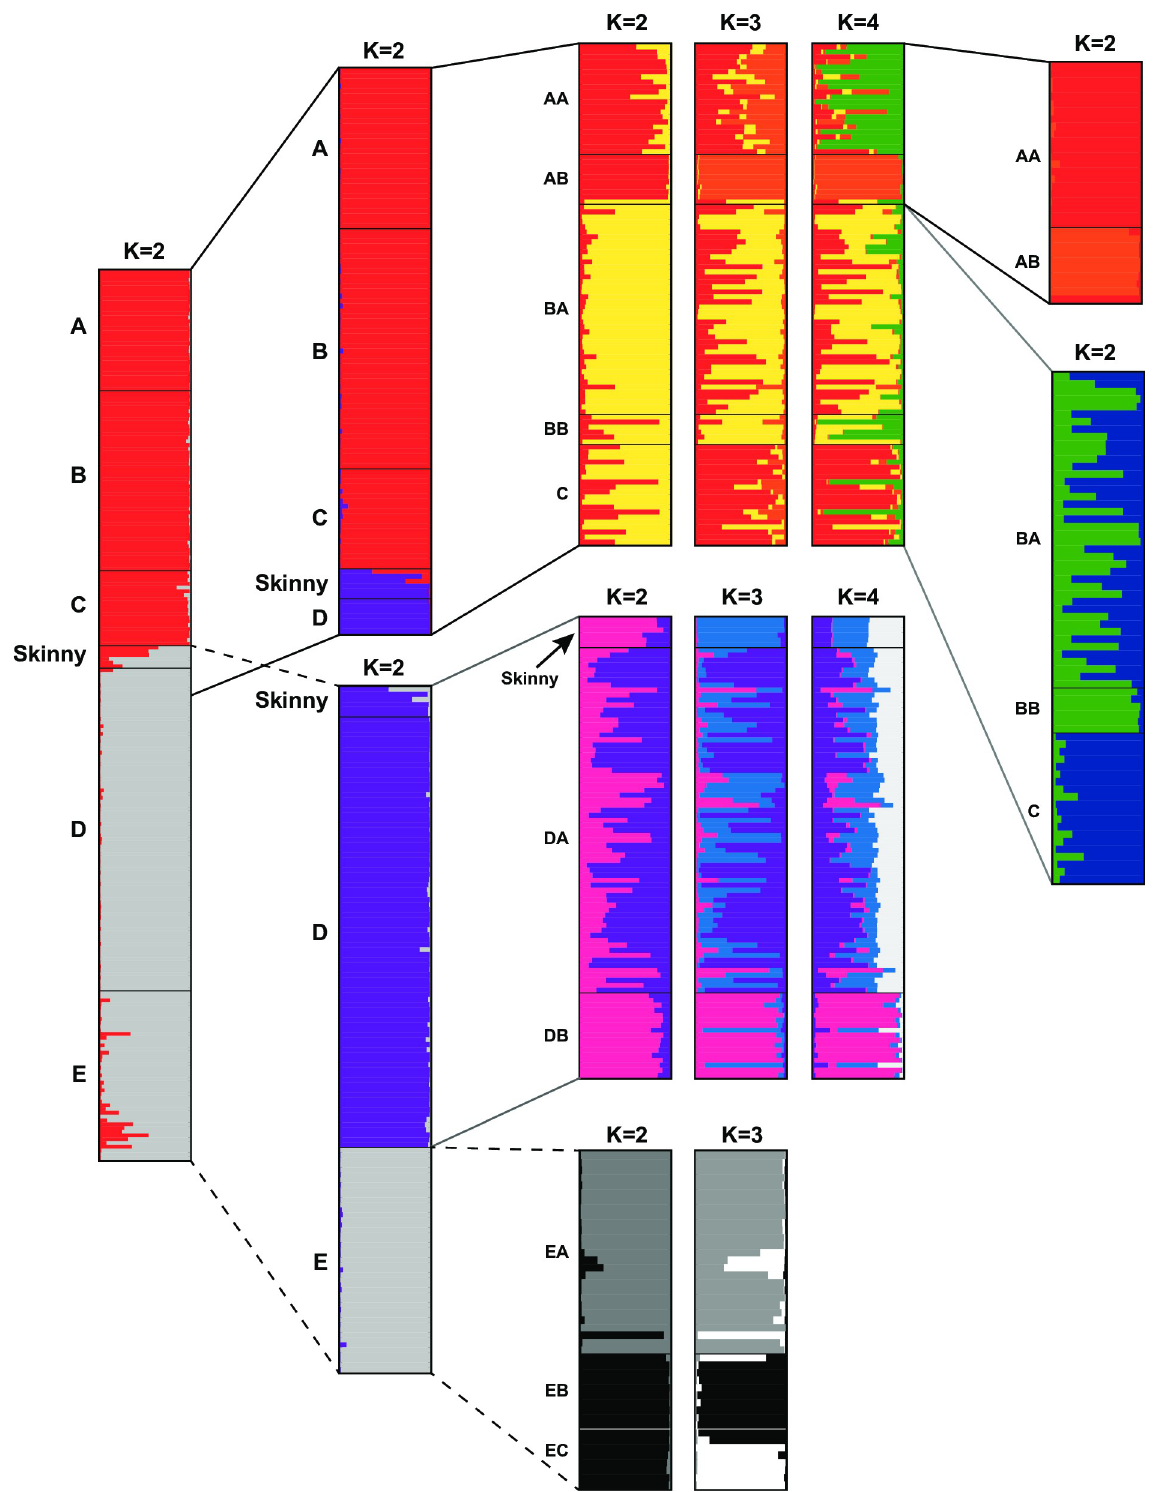
Fig 4. Individual assignment plots from nested Bayesian assignment tests in STRUCTURE. Results at alternate values of K are shown for some subsets of individuals.